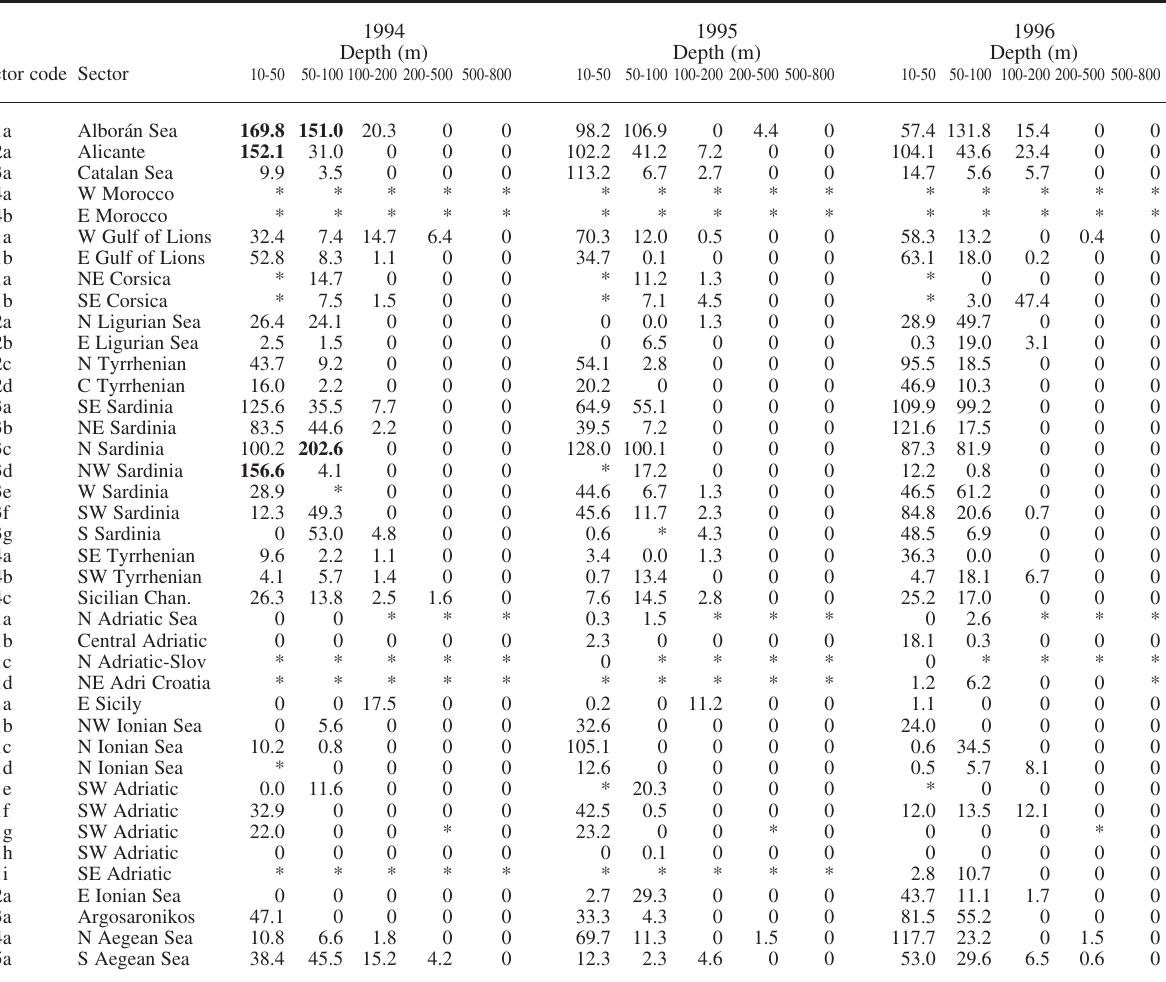
Table 3.- Octopus vulgaris : Mean biomass (kg/km 2 ) estimated from the MEDITS trawl surveys by depth stratum, geographical sector and year (1994-1999). Not sampled strata are indicated by ‘*’. Values higher than 150 kg/km 2 are presented in